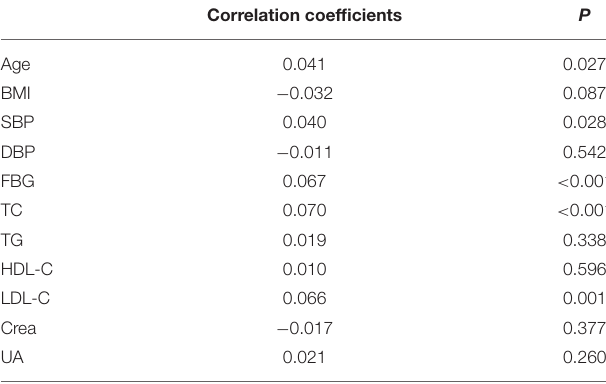
TABLE 2 | Spearman’s correlation of BHB with traditional CAD risk